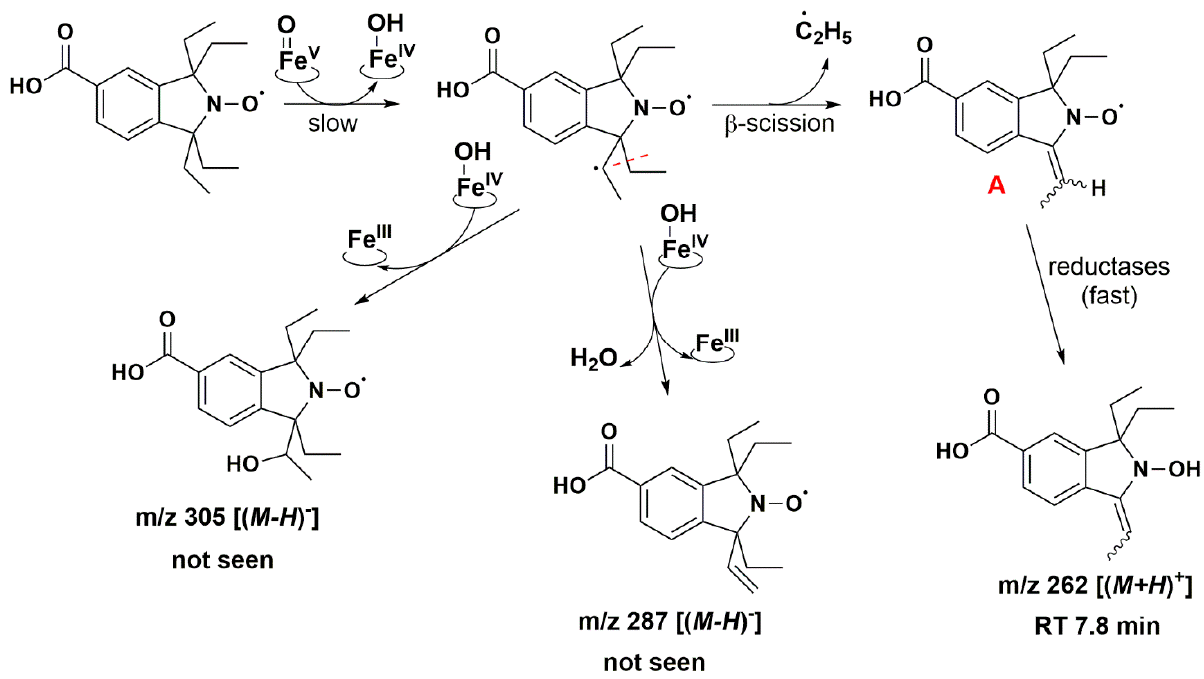
Figure 8. Proposed reaction pathways in the aerobic transformation of nitroxide 5 by RLM and NADPH, part I. Explicit hydrogen in structure A corresponds to potential origin of the coupling seen in the EPR spectra. Initial hydrogen abstraction could occur on either of the ethyl groups leading to isomers. Only one possibility is presented for the sake of clarity. The given RT values correspond to the reconstructed chromatograms of the principal ions obtained in HRMS study and are characterized by a delay of 0.2 min compared to the UV-Vis detection (see Figure